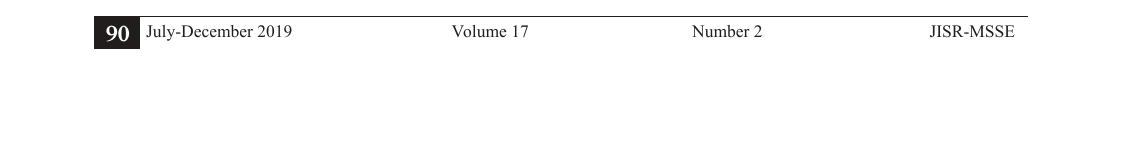
Risk Perception Investors Investment H1